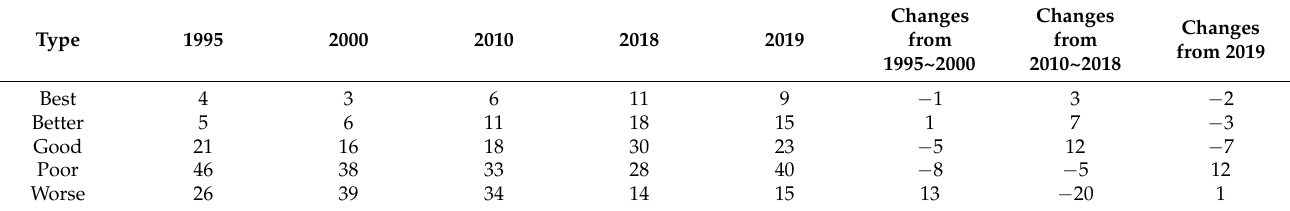
Table 2. Changes in the number of different types of energy security